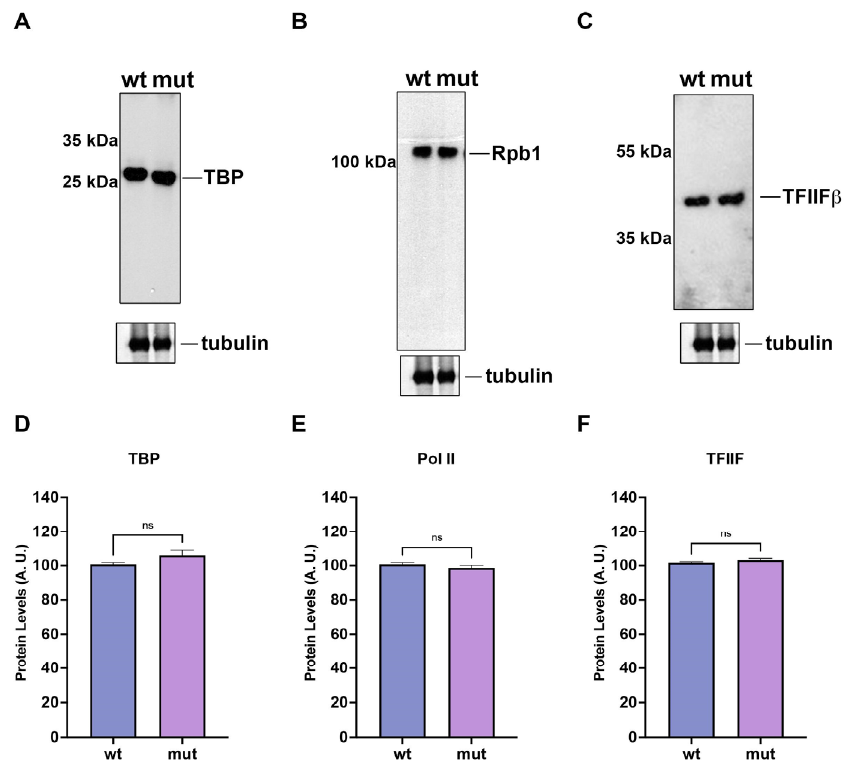
Figure 4. Transcription factors TBP, TFIIF and RNAPII levels do not vary in the fission yeast sua7::Pcsua7-kanMX6 strain. Fission yeast whole cell extracts were prepared from wild-type (wt) and TFIIB-replaced (mut) strains and the levels of the transcription factors and RNAPII were determined by Western blots using 2 µ g of whole cell extract and anti-TBP ( A ), anti-CTD ( B ) and anti-TFIIF β ( C ) antibodies. Bottom panels indicate the presence of tubulin as internal control. Quantification of Western blots of TBP ( D ), RNAPII ( E ) and TFIIF ( F ) are indicated. ns indicates non-significant differences after Student’s t -test.